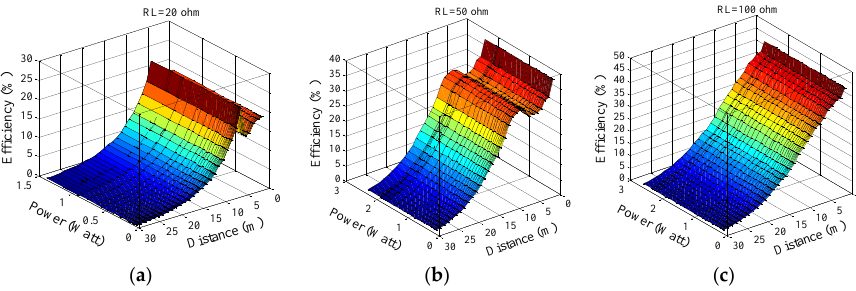
Figure 16. The relationship between output power and transfer efficiency versus distance with the following loads: ( a ) 20 Ω ; ( b ) 50 Ω ; and ( c ) 100 Ω .